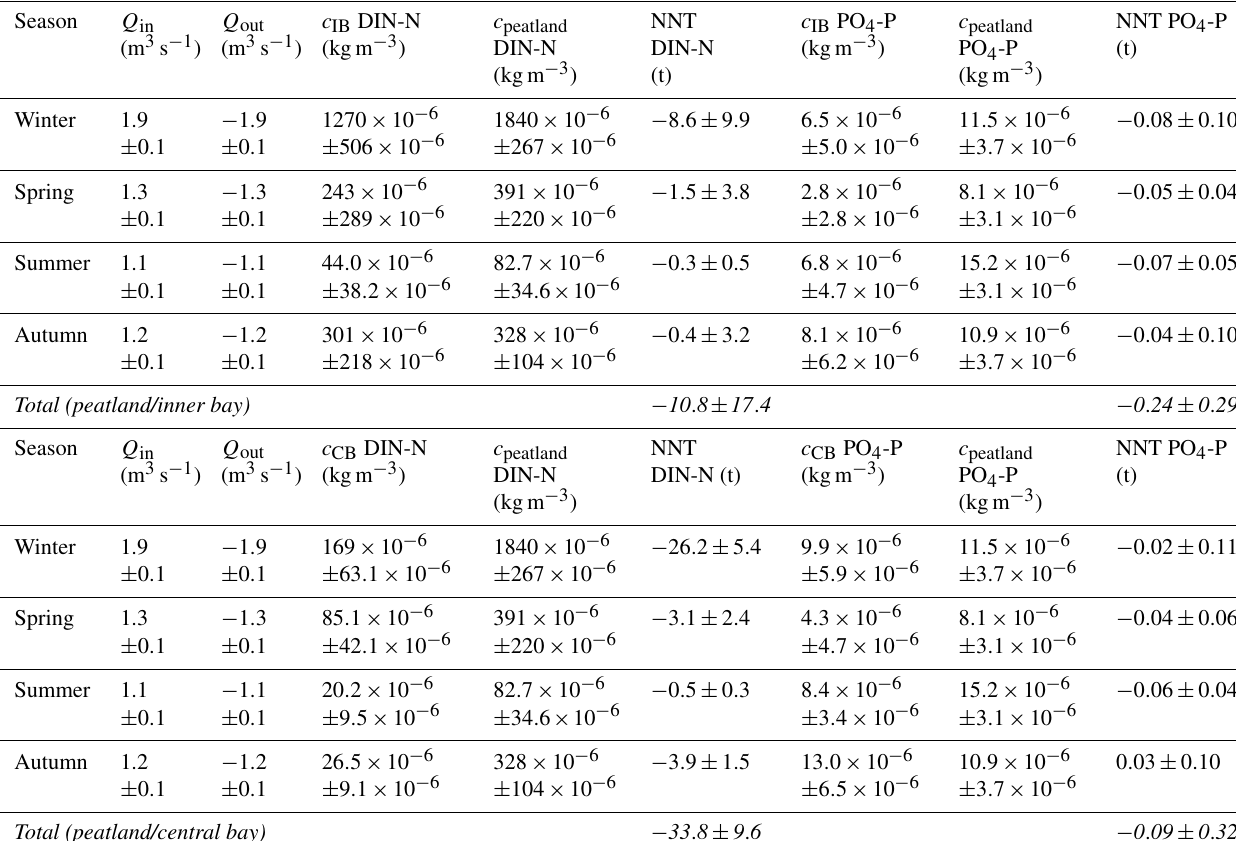
Table B1. Mean seasonal water volume exchanges ( Q in /Q out ; m 3 s − 1 ) and nutrient masses (kgm − 3 ) in the inner bay ( c IB ), central bay ( c CB ), peatland ( c peatland ), and the resulting net nutrient transport (NNT; in tonnes) for DIN-N and PO 4 -P. Negative values of NNT indicate an export from the peatland into the inner bay/central bay, and vice versa. All errors are given as the 95% confidence